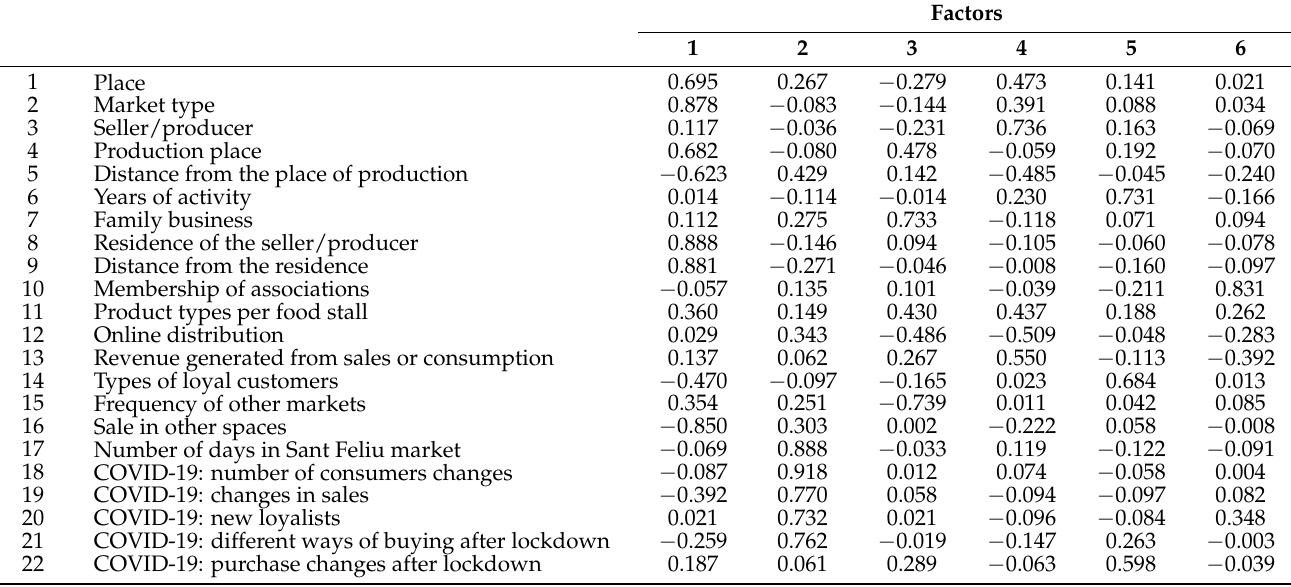
Table A2. Results from the factor analysis. Rotated component matrix a .